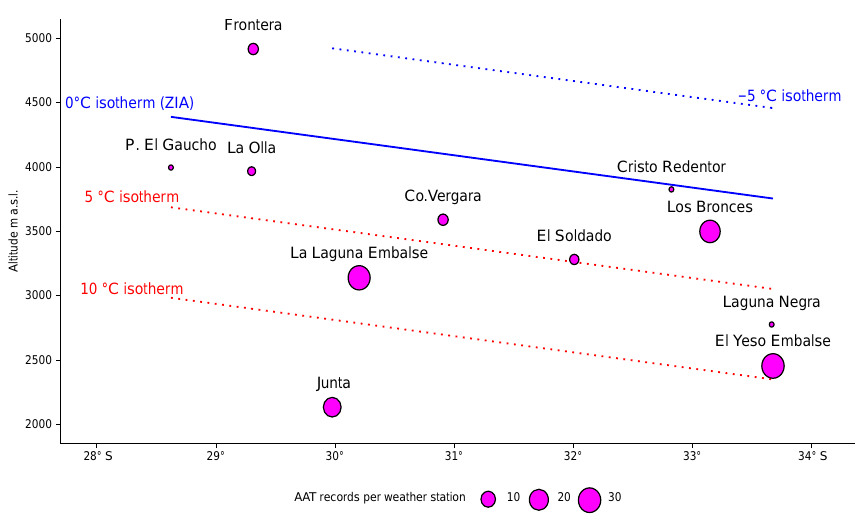
Figure 4. Altitudinal and latitudinal distribution of modelled AAT (lines) and AAT records per weather station. Table 3. Distribution of areas favourable for permafrost in the semi-arid Chilean Andes by watershed. Watershed ∗ Permafrost favourability Huasco km 2 Elqui km 2 Limarí km